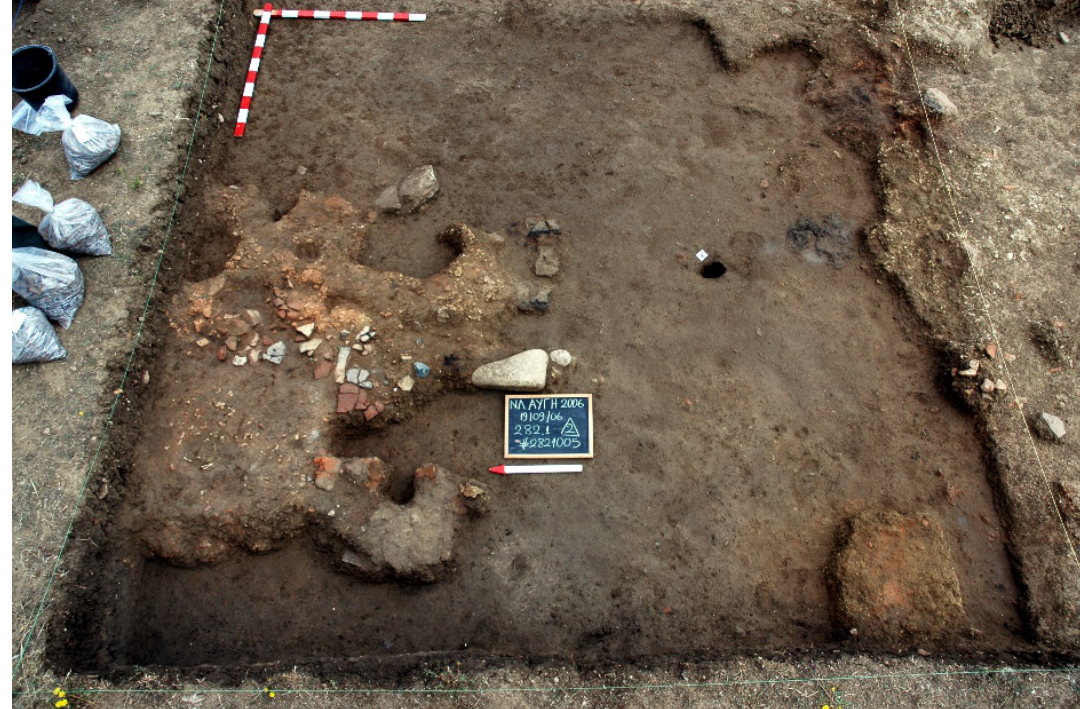
Figure 15. Grinding slabs, tools, pottery and thermal structure remains located in an AVGI II open